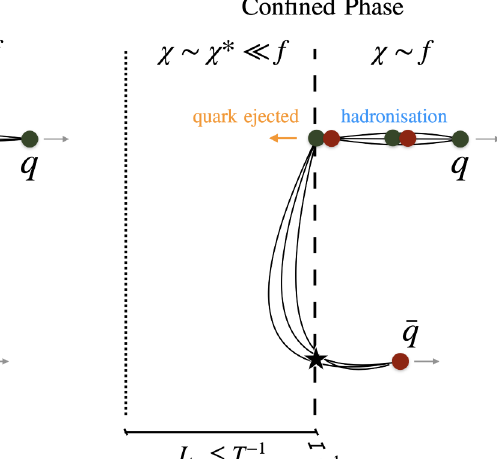
Figure 3 . The string inside the wall breaks, producing hadrons (sec- tion 4.4), and a quark is ejected from the wall (section